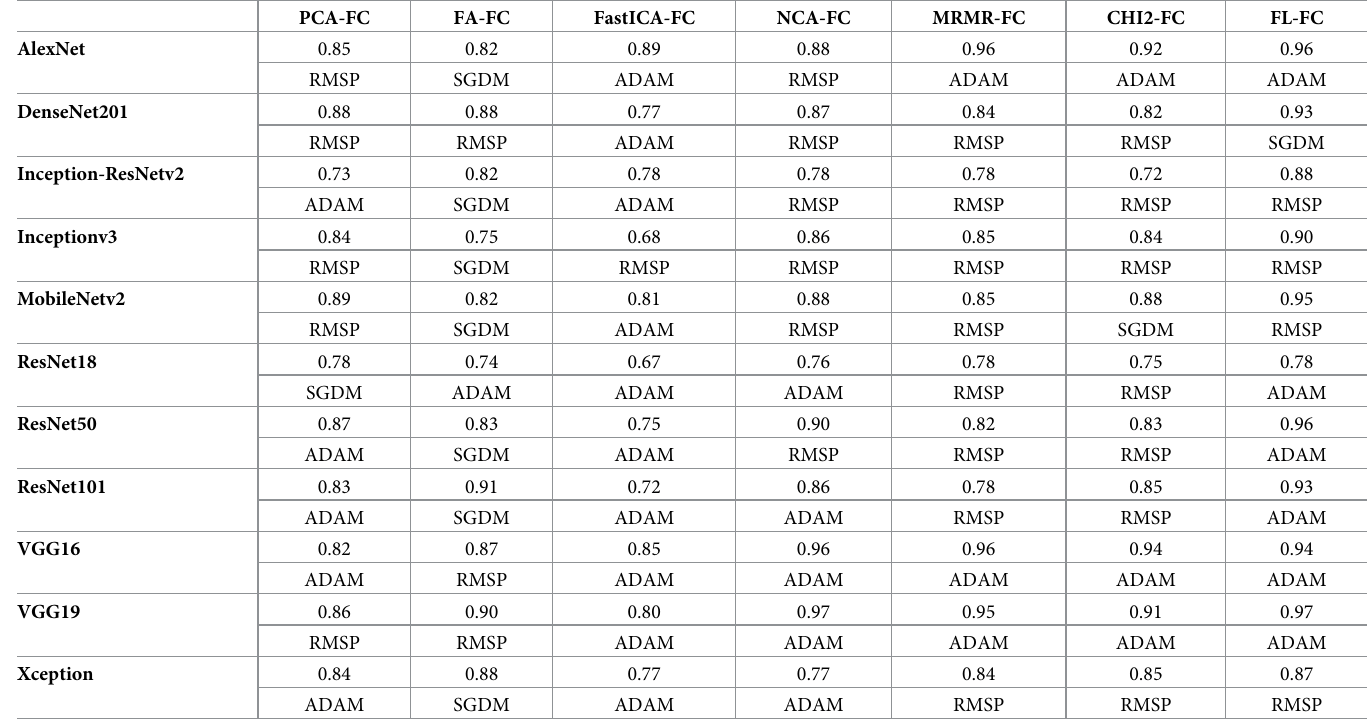
Table 11. The best FC learning optimizer for each combination method and its average classification performance (using Accuracy metric). PCA-FC FA-FC